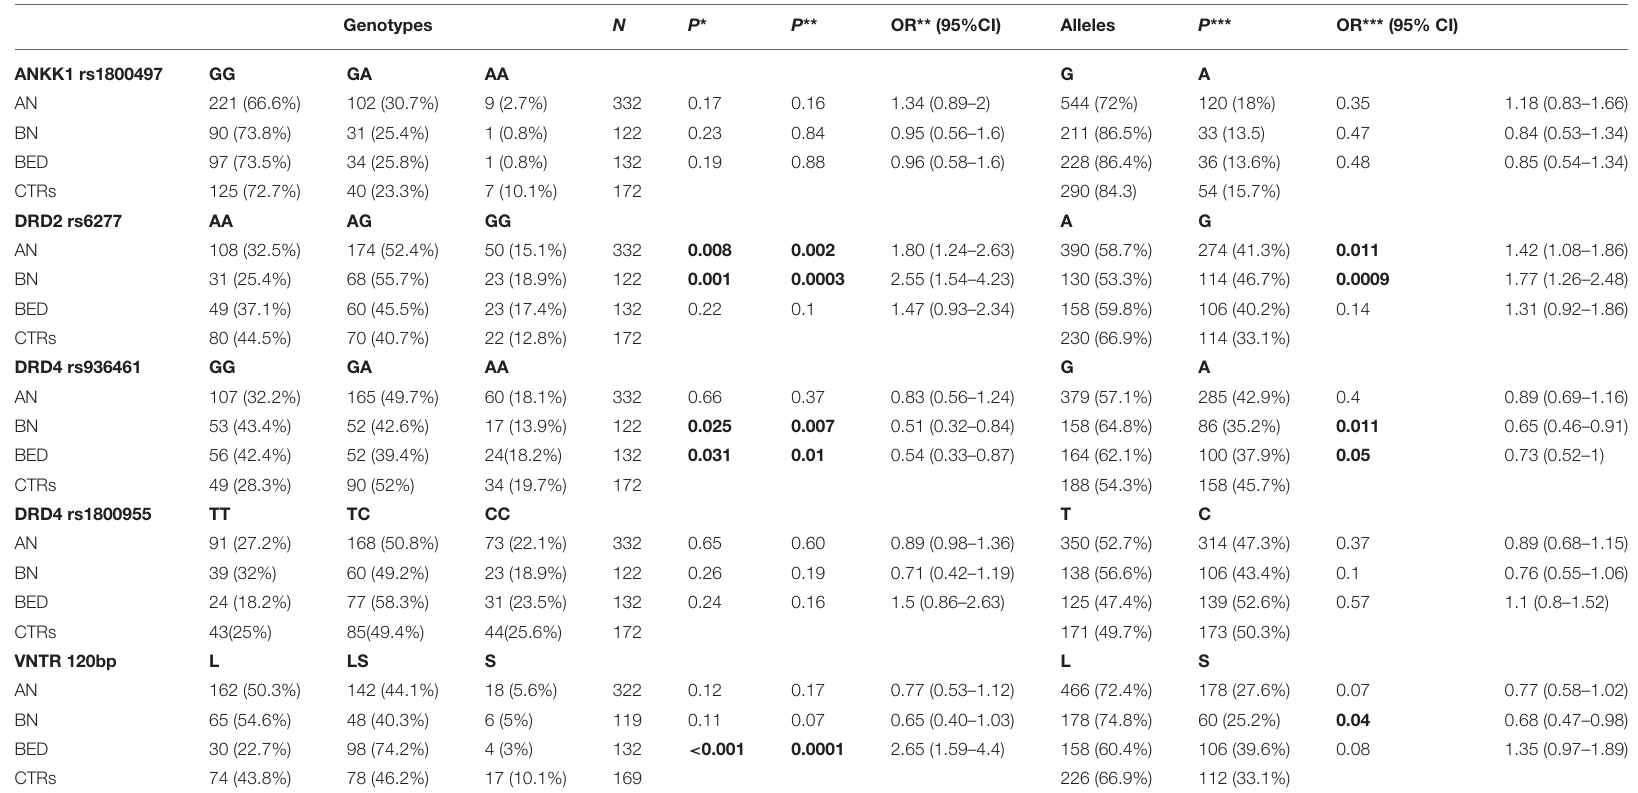
* Comparison among the three genotypic classes. ** Comparison among heterozygotes and variant homozygotes (combined together) vs. wildtype homozygotes. *** Comparison among alleles. P-values in bold indicate significant